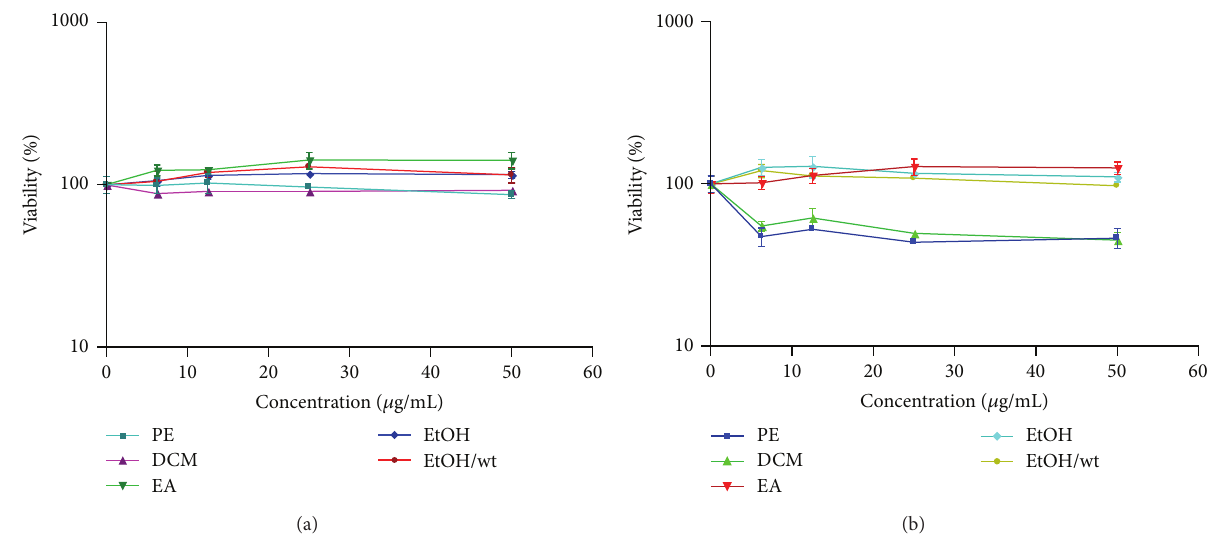
Figure 2: Cell viability of H9c2 cells after exposure to (a) A. biennis and (b) A. ciniformis Cells were treated with different concentration of extracts for 24 h. The cell viability was determined by MTT assay. Data are expressed as the mean ± SEM of three separate experiments ( 𝑛 = 6 ).